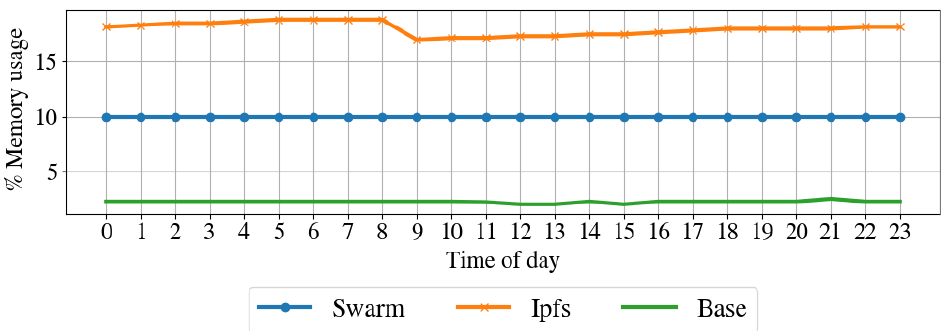
Figure 11. System average memory usage before and while running the proposed architecture with IPFS and Swarm implementation.